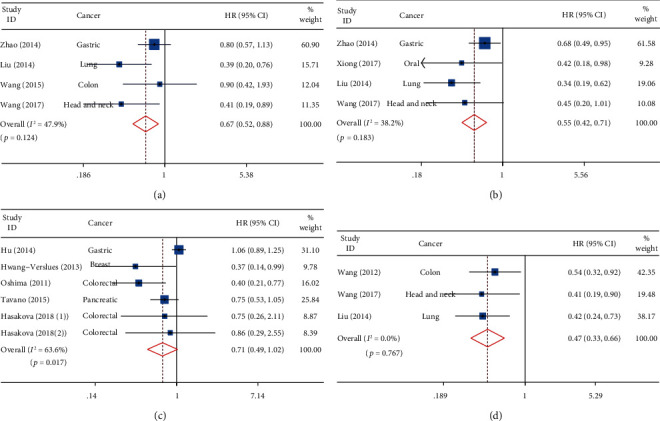
Forest plot of the HR for the relationship between PER family expression and OS. (a) Pooled HR for PER1 protein expression and OS. The detection method of PER1 protein level was IHC. (b) Pooled HR for PER2 protein expression and OS. The detection method of PER2 protein level was IHC. (c) Pooled HR for PER2 mRNA expression and OS. The detection method of PER2 mRNA expression was qRT-PCR. (d) Pooled HR for PER3 protein expression and OS. The detection method of PER3 protein level was IHC.